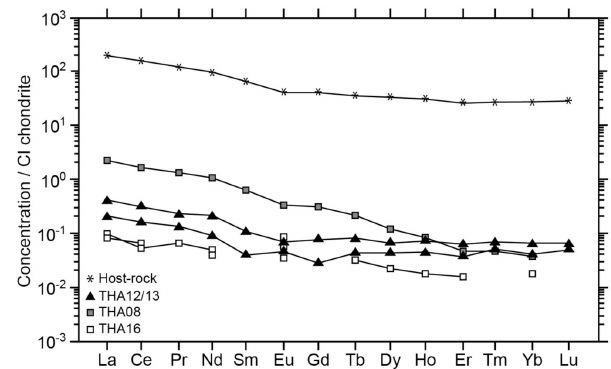
Figure 11. REE spider diagram of blue-green (THA16), yellow (THA08) and orange (THA12 and THA13) kyanite individual crystals and of the host rock sample CS16_292b. The normalizing factors are related to CI chondrite values